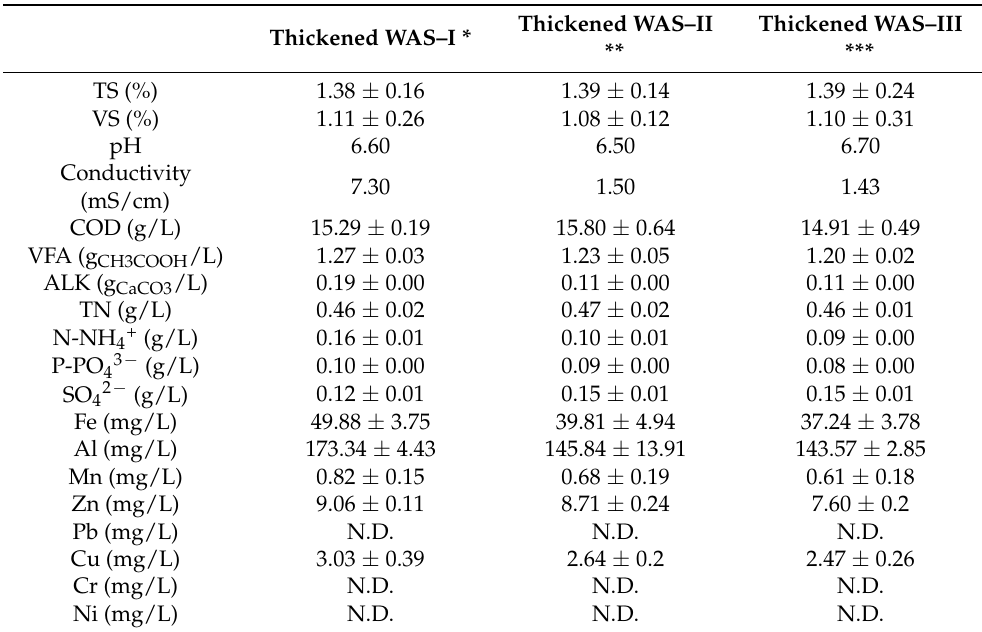
Table 1. Substrate